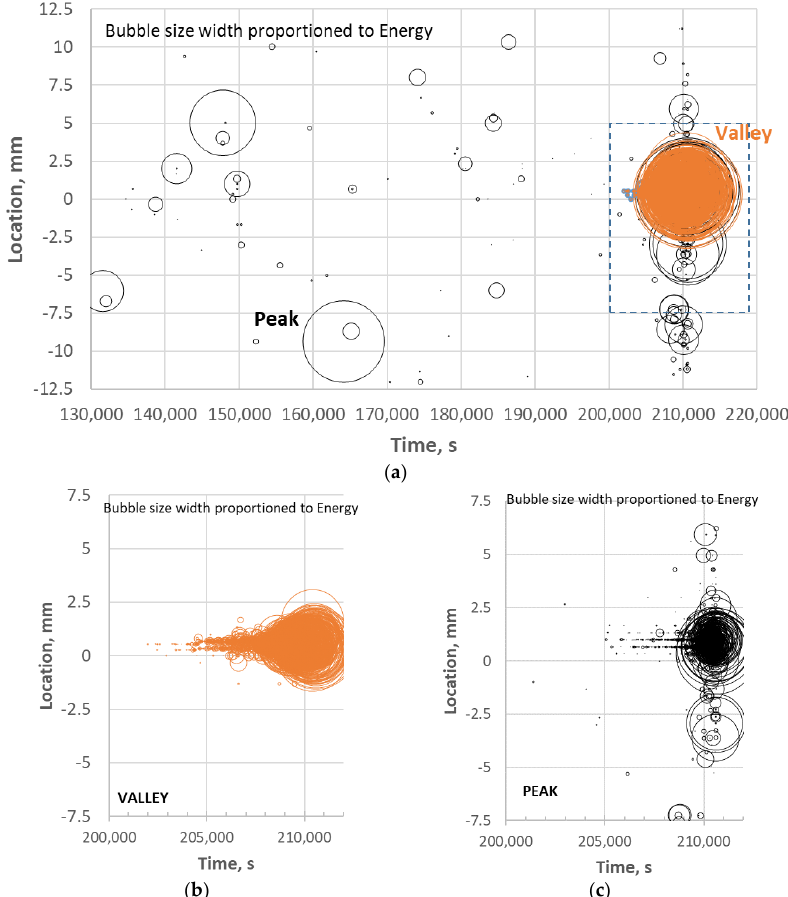
Figure 7. AE location analysis distinguishing between “peak” and “valley” events for: ( a ) the last half of the test; and for the ( b ) valley and ( c ) peak events for the last ~3 h of the test for 113-3.